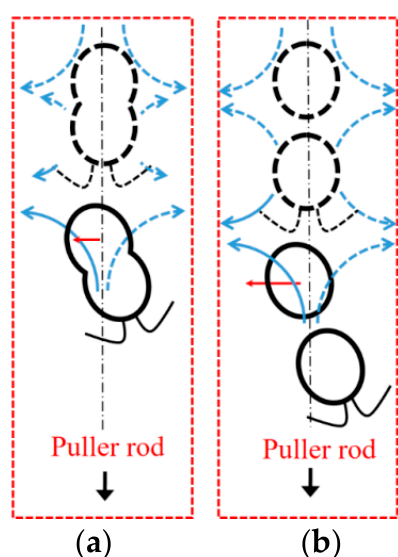
Figure 15. Mechanism of the rotational tendency of pushers and pullers with different values of s : ( a ) s = 0.75 d ; ( b ) s = 1.5 d.